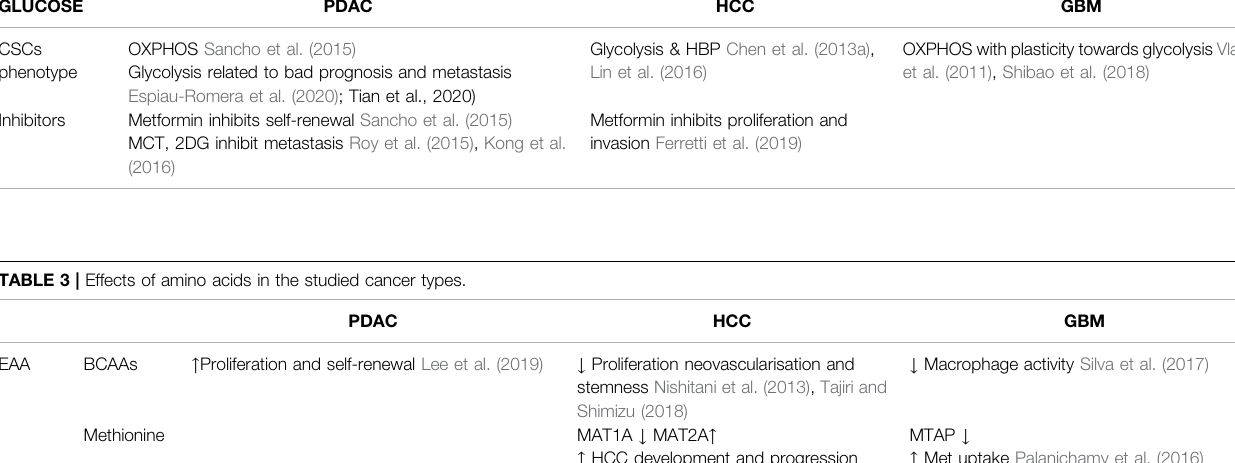
TABLE 2 | Effects of glucose in the studied cancer types. GLUCOSE PDAC